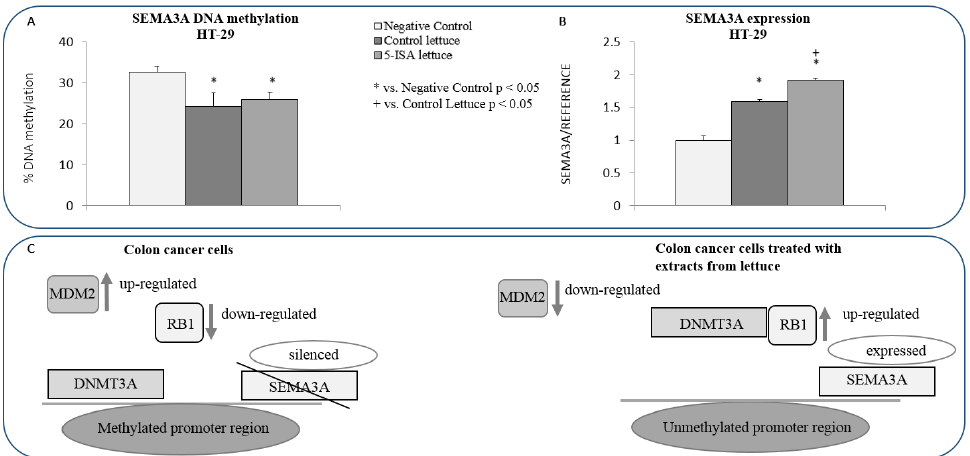
Figure 6. The effect of extracts from iodine-biofortified lettuce on DNA methylation ( A ) and expression of SEMA3A. ( B ) in human cancer cells of HT-29 cell line. ( C ) Schematic of proposed mechanism of hypomethylation and upregulation of SEMA3A tumor suppressor gene by extract from 5-ISA-fortified lettuce. Cells were treated with 1000 µg/mL extract from control lettuce, or 5-ISA-fortified lettuce. The results are shown as means ± SD. Statistical significance of treatment was assessed using t -test * vs. negative control when p < 0.05; + vs. control lettuce when p <